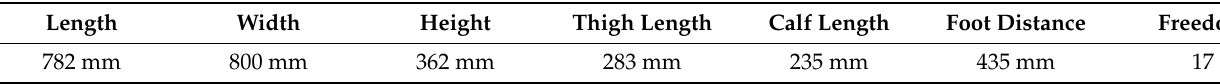
Figure 2. Structure of the robot. Table 3. Major parameters of the robot.